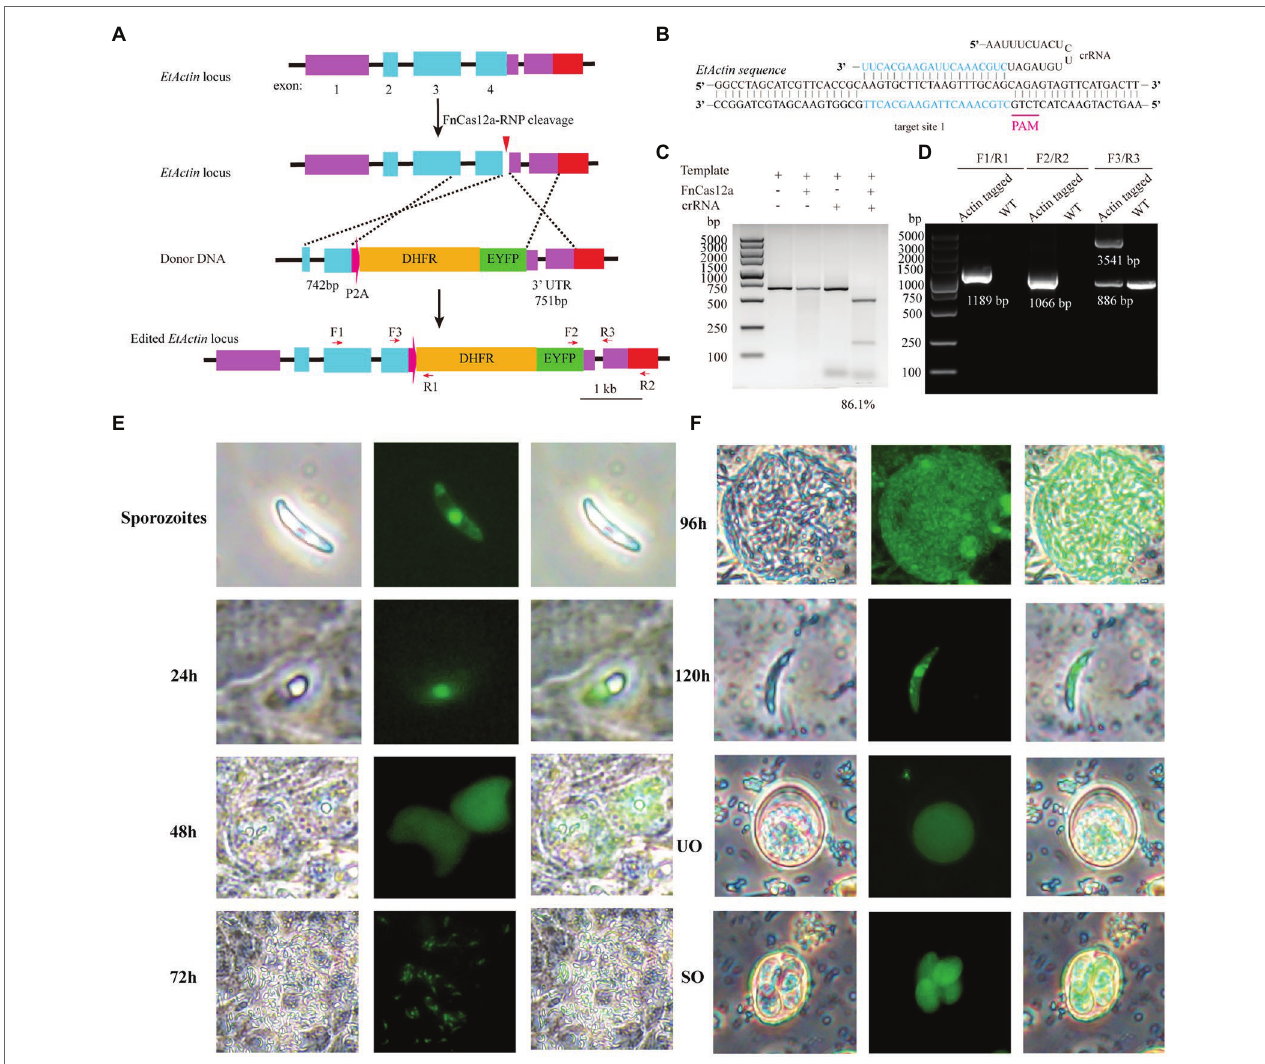
FIGURE 3 | FnCas12a-mediated EtActin gene knock-in. (A) Schematic diagram illustrates FnCas12a-mediated knock-in at EtActin . E. tenella sporozoites were transfected with FnCas12a-RNP and homologous recombination template (P2A-DHFR-EYFP cassette in-frame with C-terminal of EtActin gene). (B) Schematic diagram of FnCas12a crRNA-DNA-targeting complex. The target sequence is in blue, and the PAM sequence is in pink. (C) In vitro cleavage of PCR products harboring the targeting sequence at EtActin . (D) PCR confirmation of EtActin tagged E. tenella and parental one (wild-type, WT). The positions of primers (F1/R1; F2/R2; and F3/R3) are shown in (A) . (E) Sporozoites of EtActin knock-in were cultured in MDBK cells and EYFP expression at different time points (24, 48, and 72 h) after sporozoites invasion. (F) The cecal smears of EtActin knock-in were prepared in 96, 120, 144, and 168 h (h.p.i.) for detection of merozoites, unsporulated oocyst, respectively. UO, unsporulated oocyst; SO, sporulated